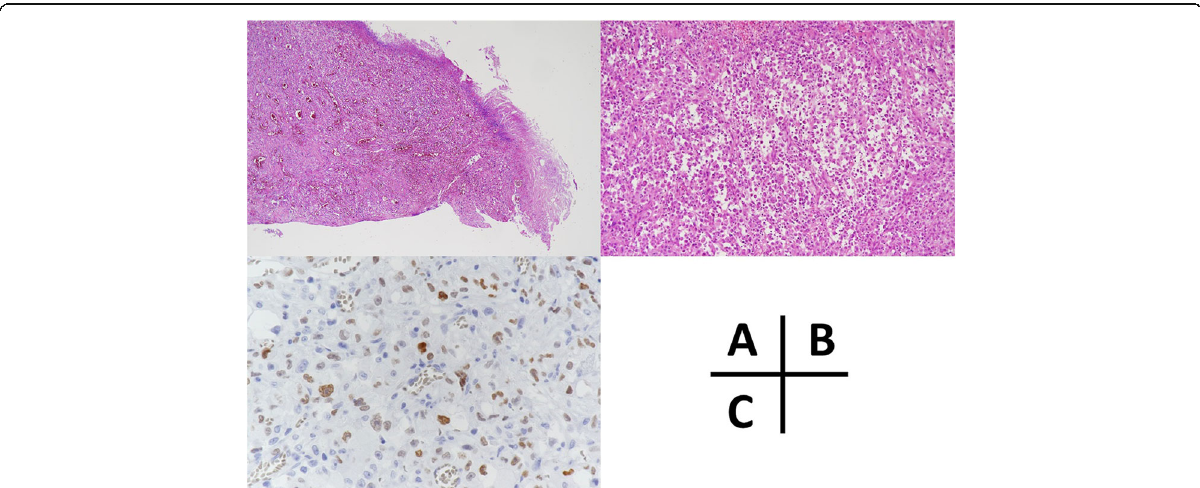
Fig. 3 Pathological examination and immunohistochemical stain for thyroid transcription factor 1 (TTF-1). a The right side of the picture was the perforated site, and tumor cells and fibrosis were observed throughout the whole layer (× 40). b There were tumor cells with high degree of degeneration and necrosis change in the perforation site (× 100). The pathological response for the efficacy of pembrolizumab was grade 1b ( Japanese Classification of the Colorectal Carcinoma , seventh edition). c The tumor cells showed TTF-1 expression in immunohistochemical